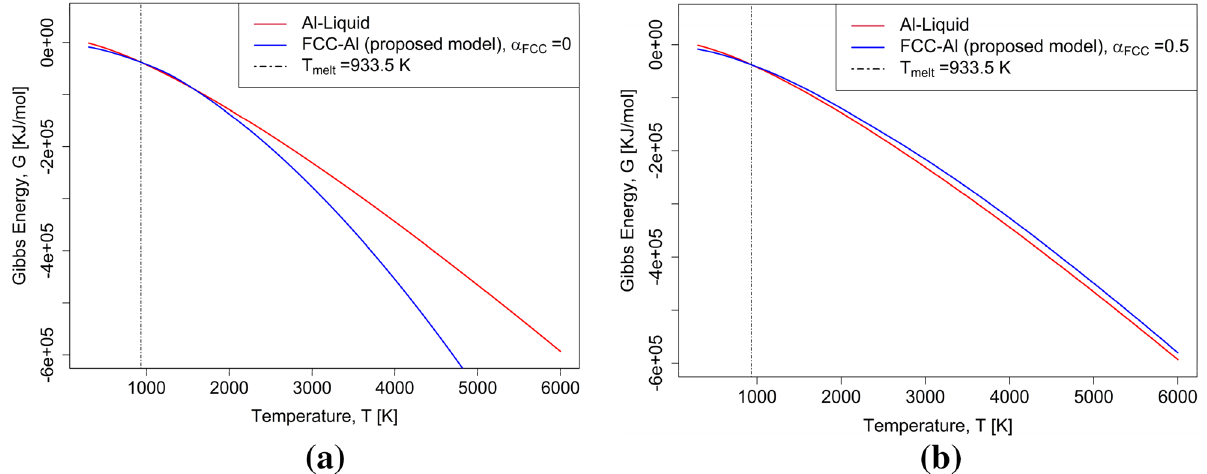
Figure 4. Gibbs energy description for FCC-Al using the proposed model compared with liquid phase 44 , ( a ) using α FCC = 0 ( b ) α FCC =